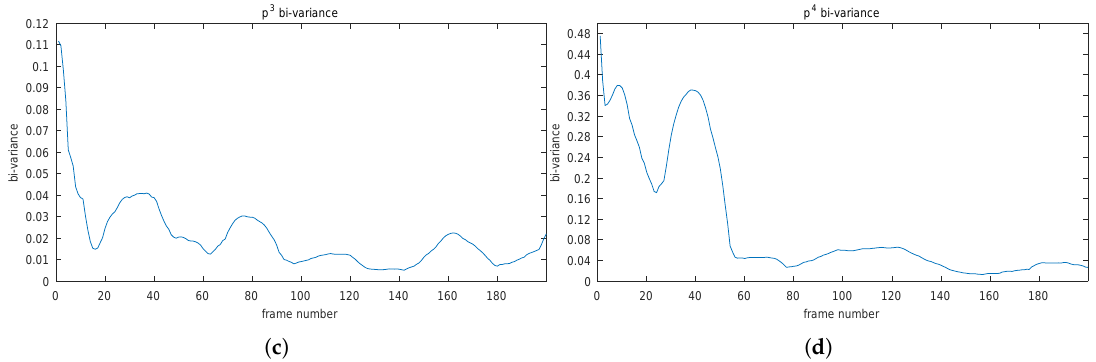
Figure 3. The bi-variance method is applied to the VCS of the four points displayed in Figure 2. Points p 1 (204, 82) in ( a ), p 2 (94, 195) in ( b ), p 3 (217, 332) in ( c ), and p 4 (15, 52) in ( d ).